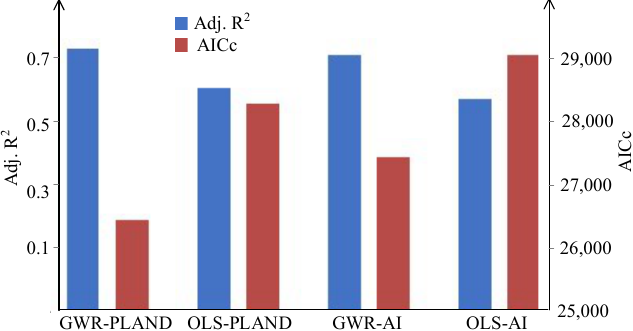
Figure 4. Performance comparison of the results from ordinary least square (OLS) regression and geographically weighted regression (GWR).